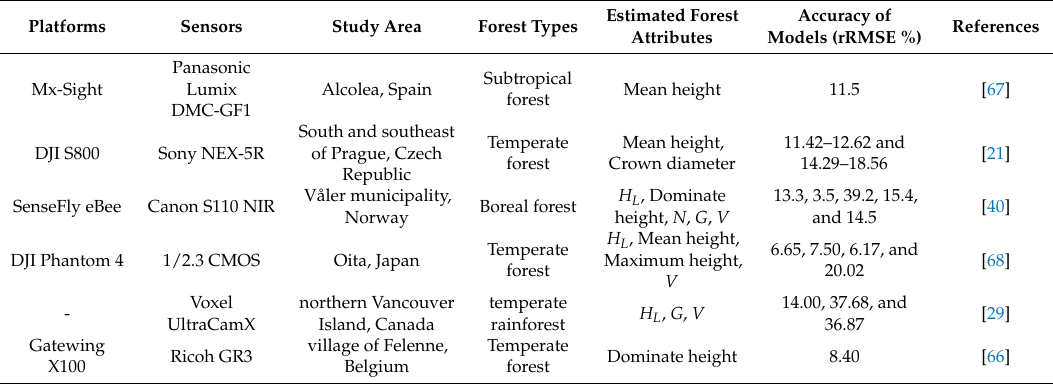
Table 8. Summary of the previous studies that estimated forest structural attributes based on